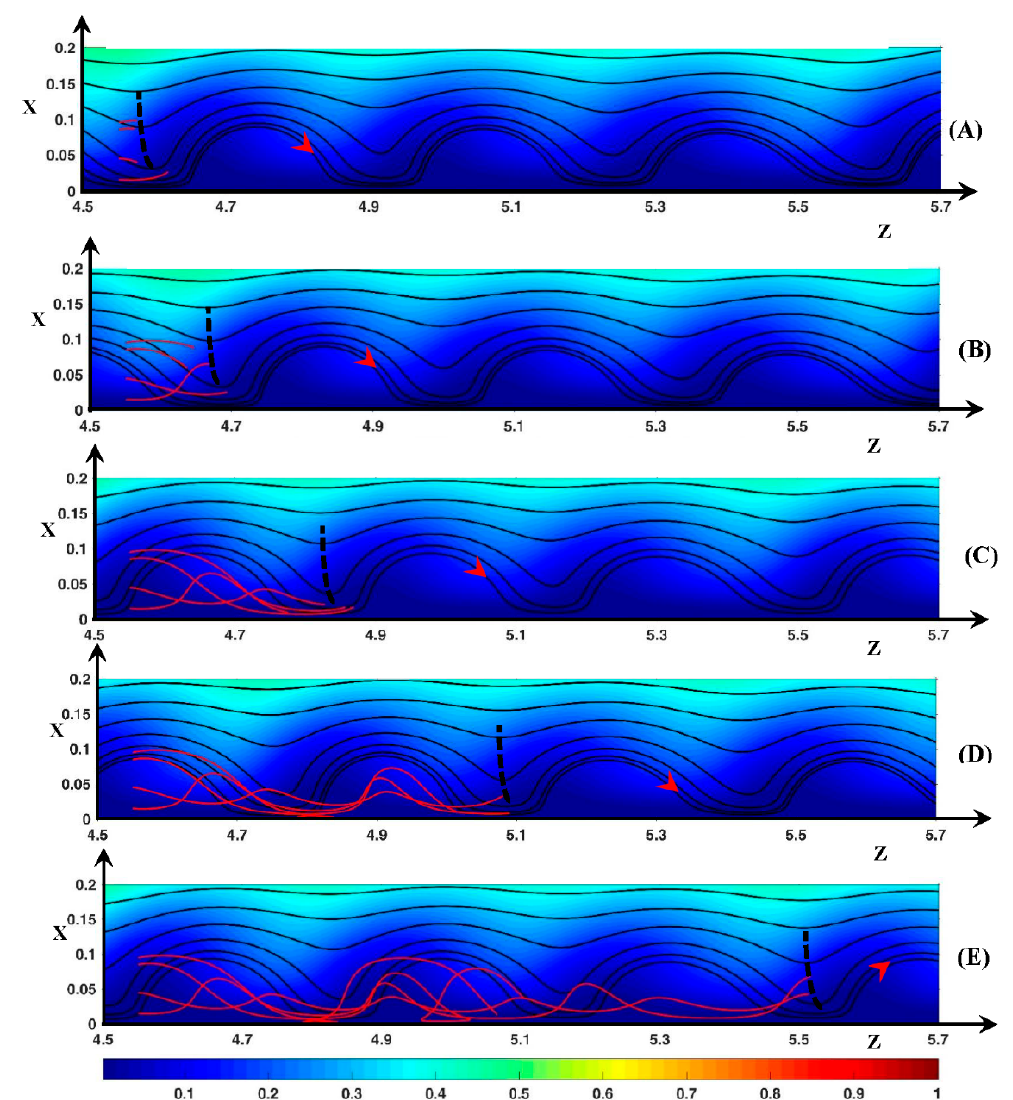
Figure 11. Fluid trajectories. Black lines: static streamlines starting from the inlet. Red lines: dynamic streamlines starting from z o = 4.55 ( x o = 0.015, 0.045, 0.085, 0.095). Black dashed line: curve defined by U x = 0. Color plot: cation concentration. The red arrow represents the rotation direction of the vortices and the position of the vortex at time t’ (this vortex is downstream the trajectories source at t ’ = 0). ( A ) t ’ = 10; ( B ) t ’ = 35; ( C ) t ’ = 80; ( D ) t ’ = 155; ( E ) t ’ = 275. ∆Φ = 22, ν = 1/3 × 10 − 3 , D ± =